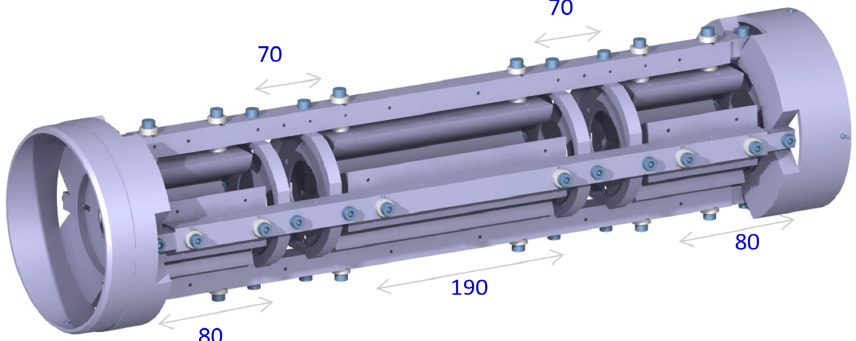
FIG. 10. Schematic view of the electrostatic quadrupole triplet: three quadrupoles with collimator in each quadrupole ’ s side.